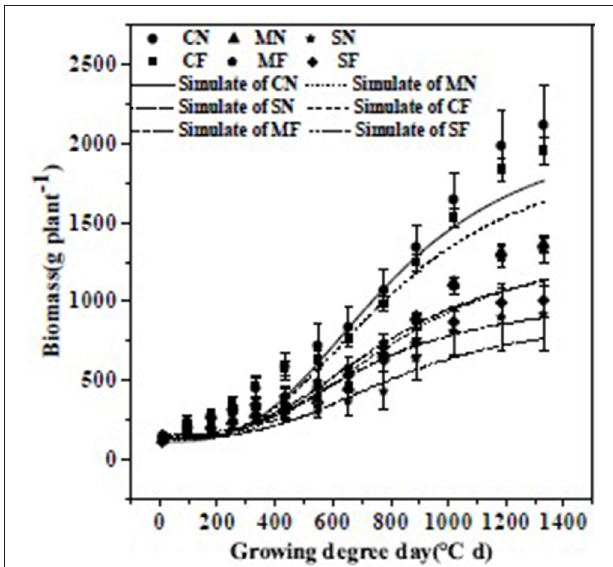
FIGURE 3 | Comparisons between the measured and simulated values (using the logistic equation) of biomass under different salinity stress and fruit thinning. Bars are means standard deviation ( n 6). Note: Trend line ± = formulas are: CN, y